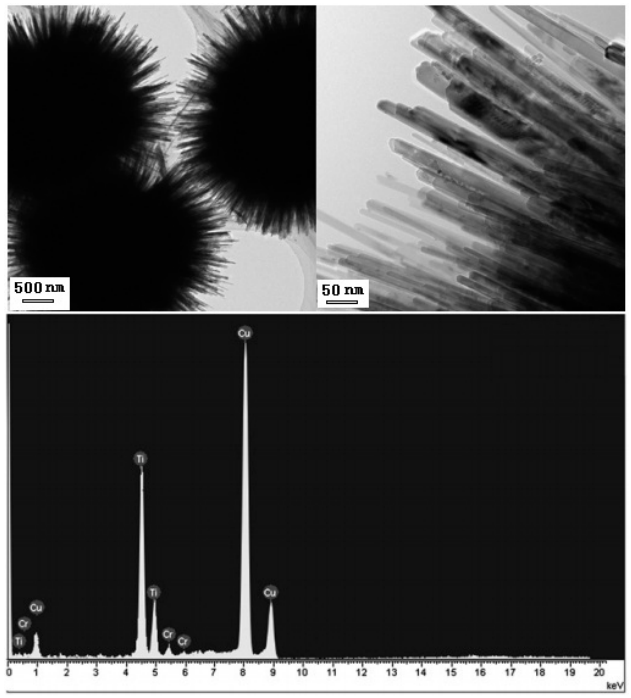
Figure 10. TEM images and EDS spectra of Cr-doped urchin-like TiO2 particles [73].